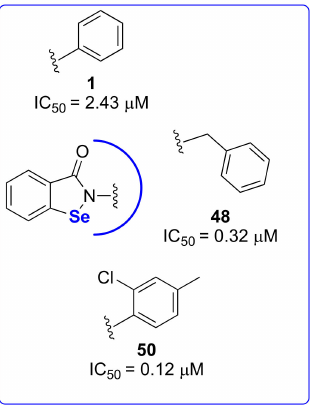
Figure 14. Structures and activity of MetAP2